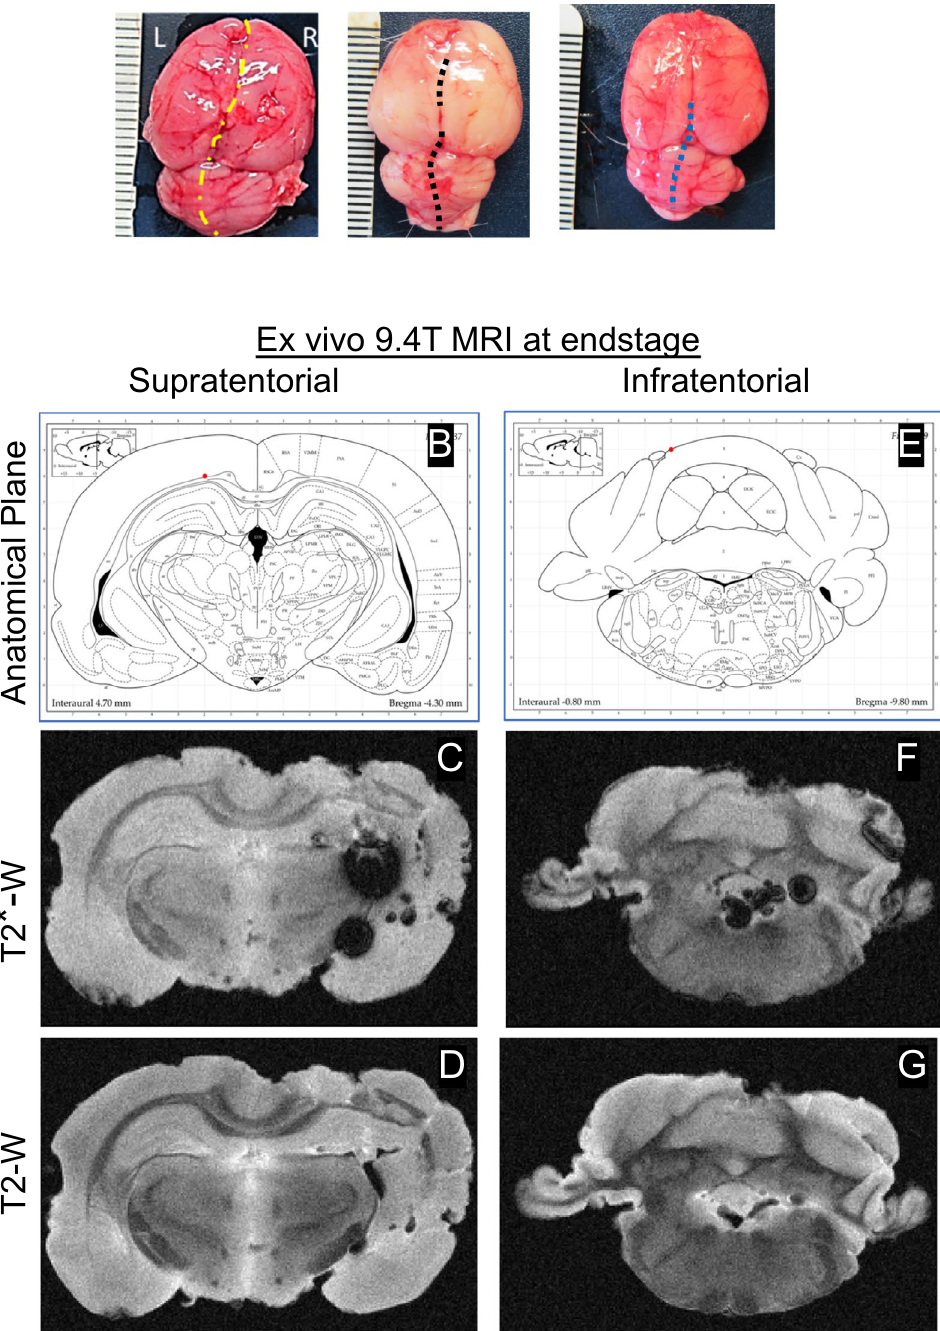
Figure 1. ( A ) Representative post-mortem images of hsICH rat brains isolated immediately after euthanasia depicts hemorrhages. ( B – G ) Representative ex vivo 9.4 T MRI of hsICH rat brain after ICH-related death showing sICH phenotype in supratentorial site ( B – D ) and infratentorial site ( E – G ) in a control rat. ( B ) Diagram of anatomical plane through thalamus, dorsal 3rd ventricle and lateral ventricles. ( C ) T2* weighted (T2*-W) intraventricular hemorrhage (IVH) in the left lateral ventricle. ( D ) T2-weighted (T2-W) image showing areas of perihematomal edema (PHE). ( E ) Diagram of anatomical plane through medulla, cerebellum, 4th ventricle and recess of 4th ventricle. ( F ) T2*-W gradient echo MRI showing IPH in the plane of the cerebellum and medulla, IVH in the 4th ventricle. ( G ) T2-W image in the same plane as ( F ) showing edema and IVH in the 4th ventricle and recess. MRI right, rat